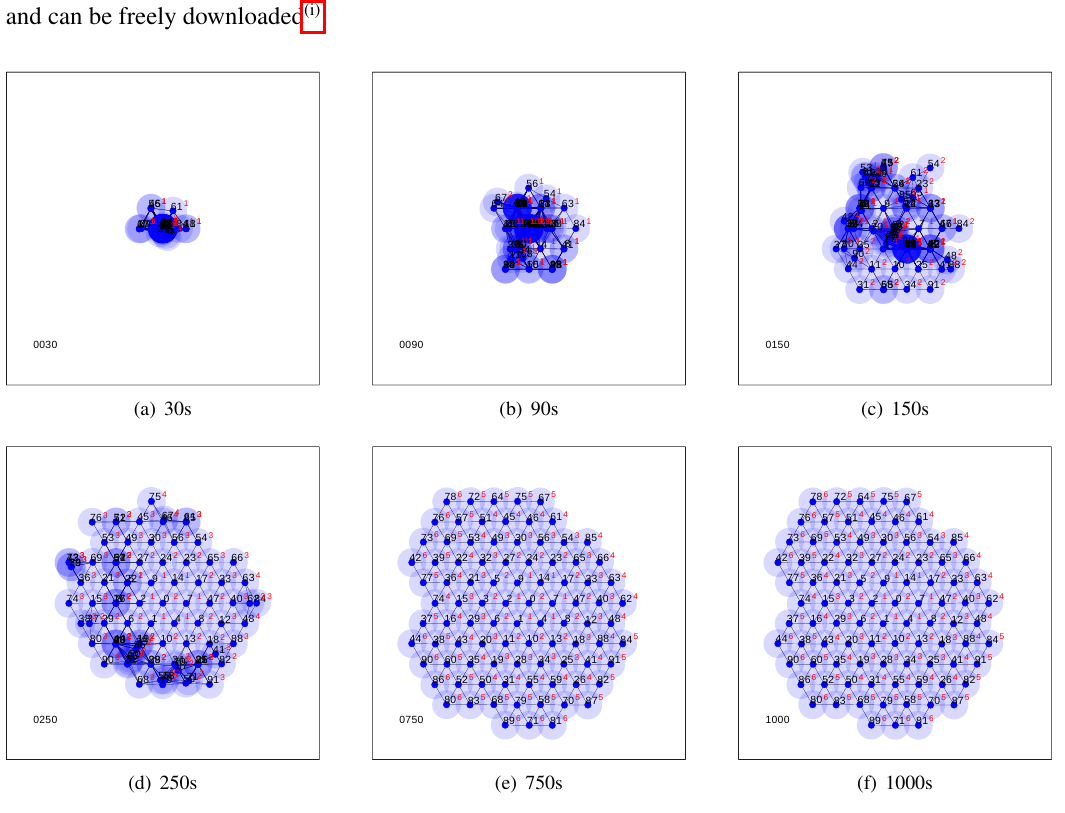
Fig. 2: Deployment snapshots of the EMR algorithm. These figures show the evolution of the deployment and the formation of the hexagonal